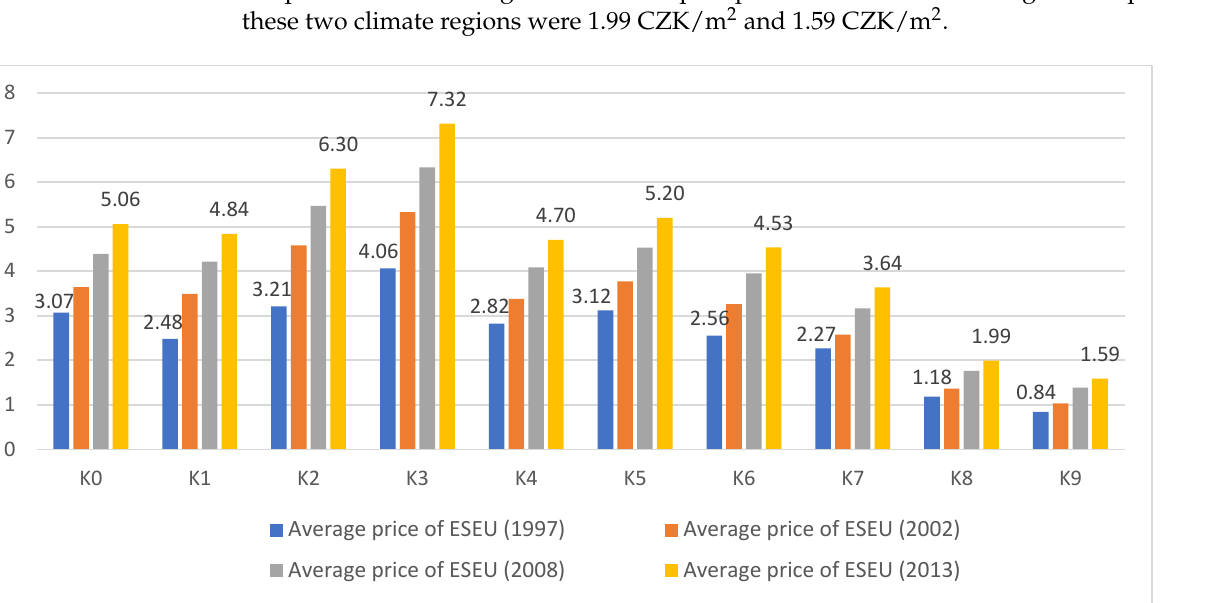
Figure 1. Development of the average ESEU prices by climate region (CZK/m 2 ).